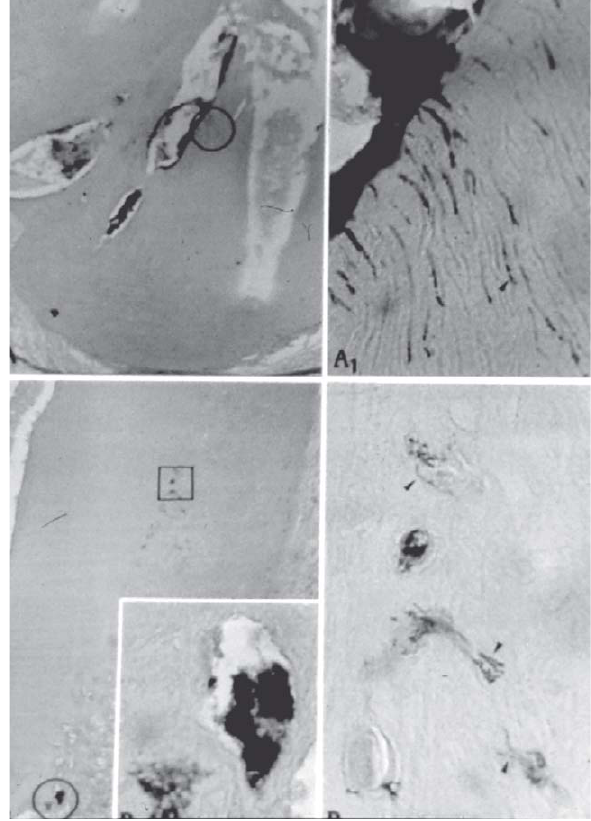
FIGURE 4- Group IV: A- Microorganisms in the canal of the apical delta - 125x. A1- Severely infected dentinal tubules- 1000x. B- Microorganisms in the cementum lacunae - 125x. B1 and B2- Cementoplasts with numerous cocci, bacilli and gram-positive filaments - 1000x. Brown & Brenn